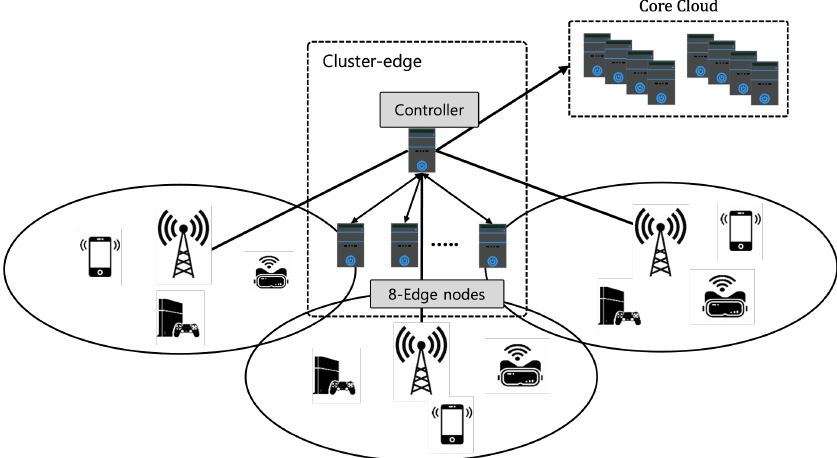
Figure 4. Network model of simulation scenario with static